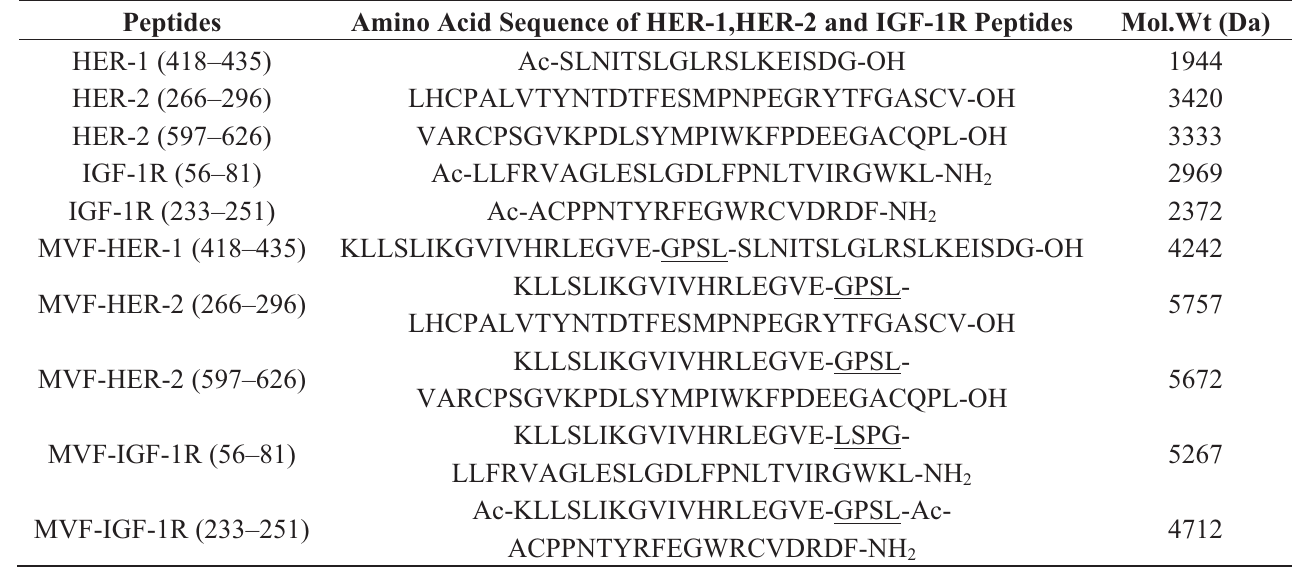
Table 1. Epitope Selection: Sequences of the peptide mimics used in this manuscript are shown above. In this study, we used five novel B cell epitopes that have been previously characterized in our laboratory and include one HER-1 epitope (HER-1-418-435), two HER-2 epitopes (HER-2-266-296 and HER-2-597-626), and two IGF-1R epitopes (IGF-1R-56-81 and IGF-1R-233-251). These epitopes were designed based on the ligand binding site of the receptor using crystallographic structures, mutagenesis studies, and models of the complex between the receptor ligand interactions. Sequences are also shown for the chimeric B-cell epitope vaccines engineered with the “promiscuous” T cell epitope of the measles virus fusion protein (MVF; italics). The flexible linker sequence GPSL was used in collinearly synthesizing the vaccines with MVF and is underlined in the table; molecular weights for each inhibitor are